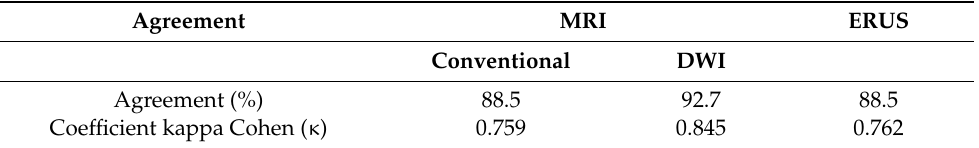
Table 3. Degree of agreement between the two observers in relation to the differences in imaging techniques